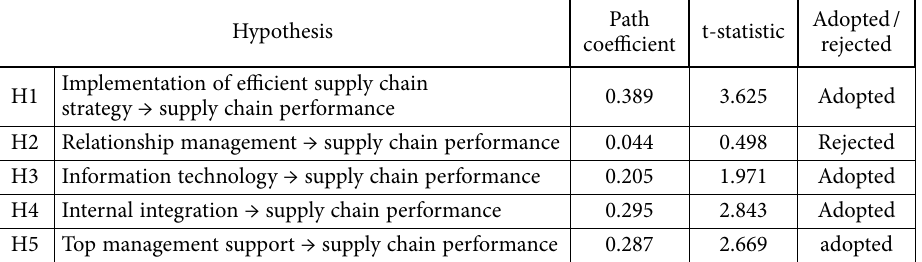
Table 5. Verification of hypotheses (summary